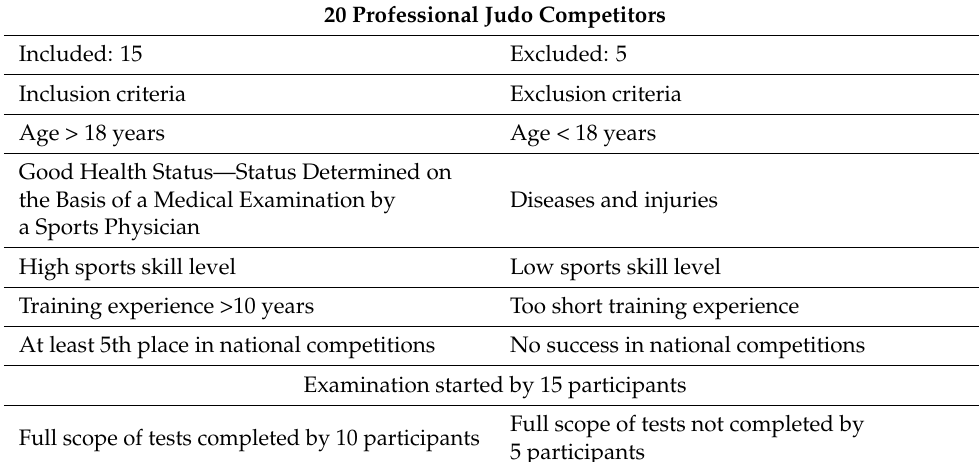
Table 1. Inclusion and exclusion